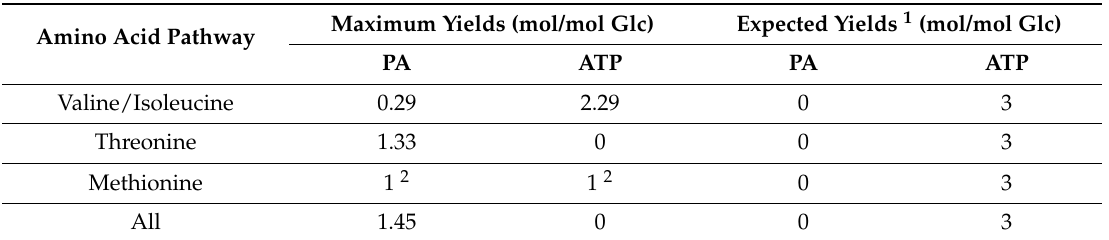
Table 8. Estimated yields for propionic acid production via degradation of amino